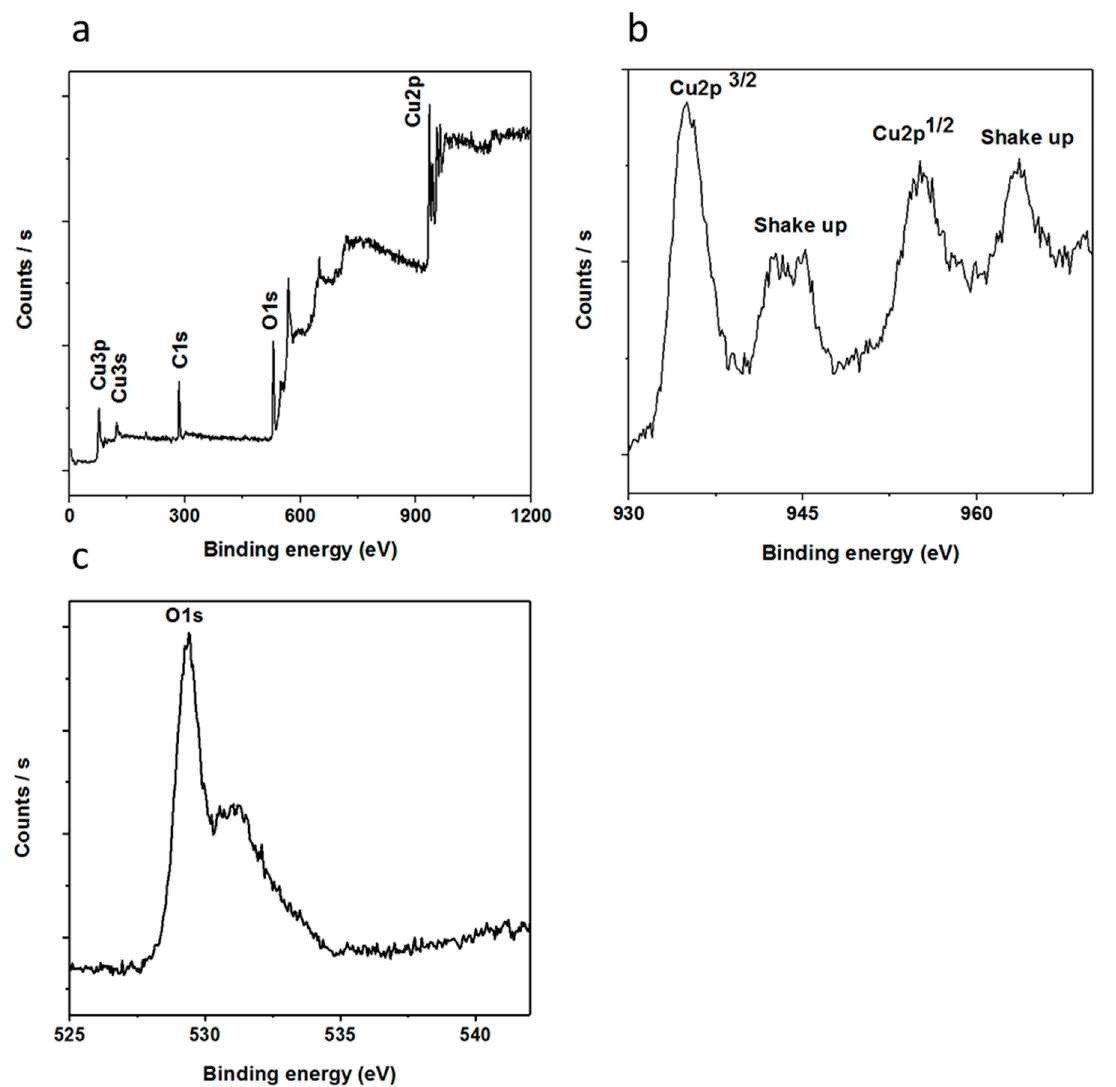
Figure 3. The XPS spectra of vitamin B 12 -assisted CuO nanostructures, ( a ) wide scan survey of elements present in the sample; ( b ) Cu 2p; ( c ) O